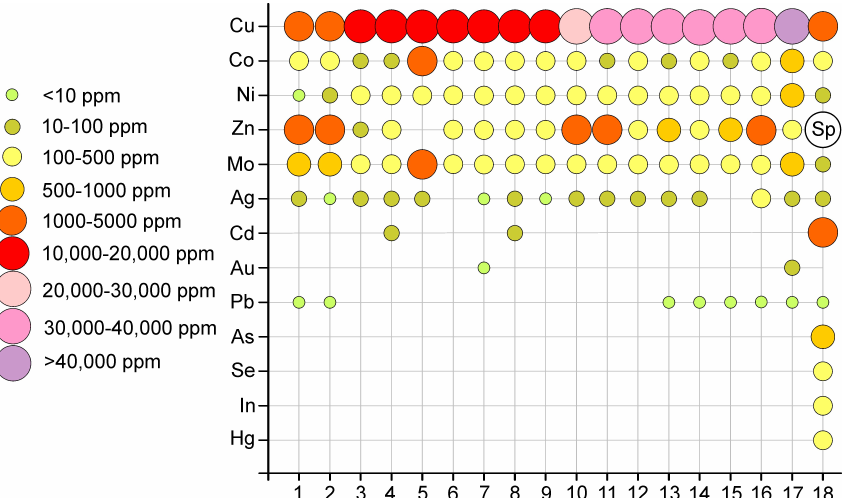
Figure 21. Visualization of the contents of chalcophilic elements in sulfide melt inclusions from zircon by LA-ICP-MS. The homogenized inclusions are represented by 1–17. Nonhomogenized inclusion of sphalerite-chalcopyrite composition—18. Sp in circle—mean sphalerite, high content of Zn, oversized in scale.